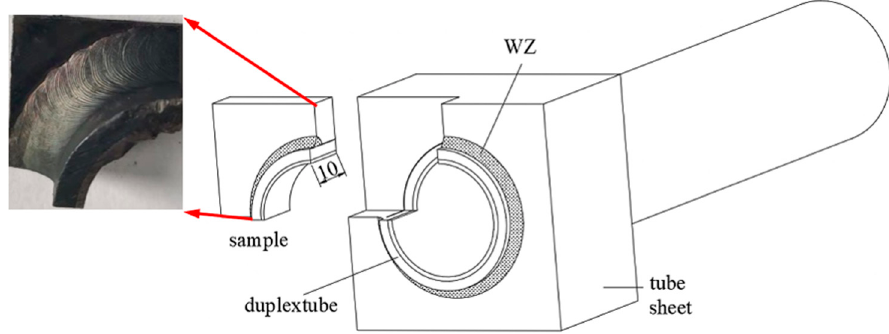
Figure 2. Schematic diagram and partial macro-drawing of welded sample.